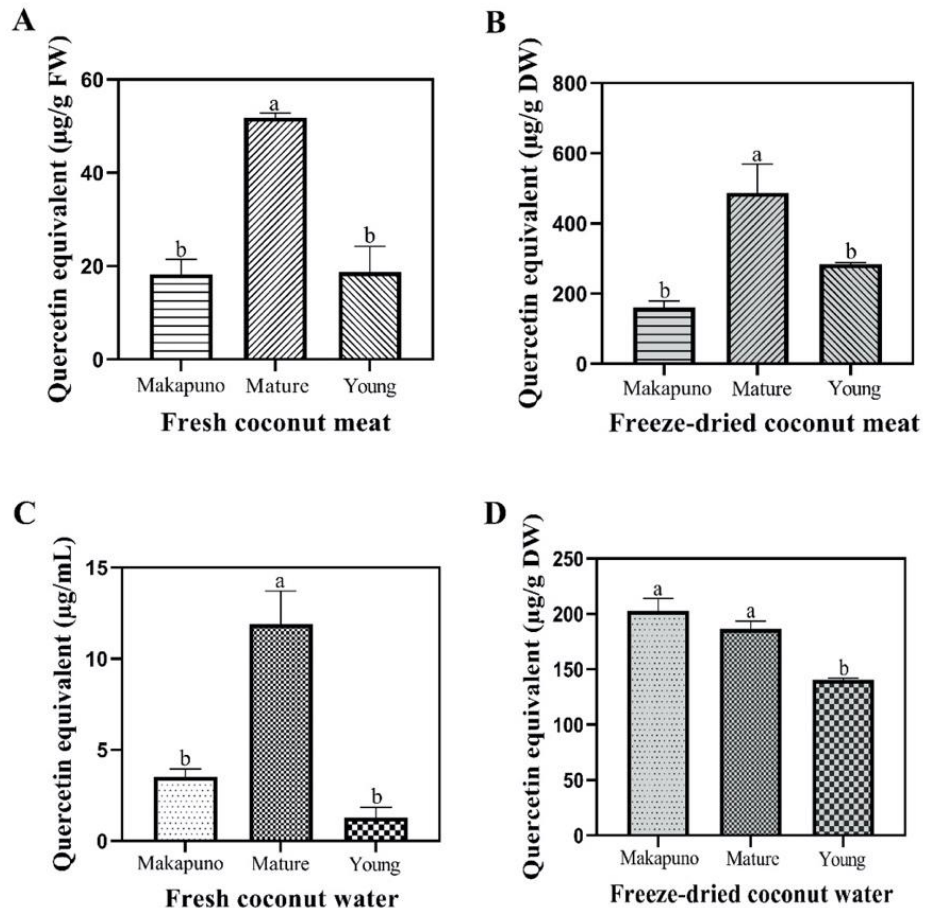
Figure 3. Total flavonoid contents of different coconut extracts. ( A ) Fresh coconut meat sample ( B ) Freeze-dried coconut meat sample ( C ) Fresh coconut water sample ( D ) Freeze-dried coconut water sample. All experiments were performed in triplicate. Data are expressed as mean ± SE (n = 3, p < 0.05) for all tested. Different letters indicate mean values significantly